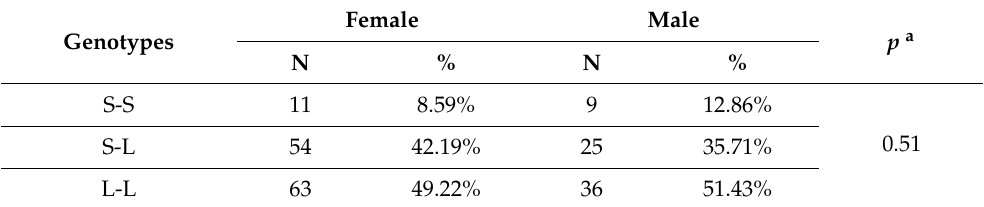
Table 5. Frequency of CNR1 genotypes according to gender.